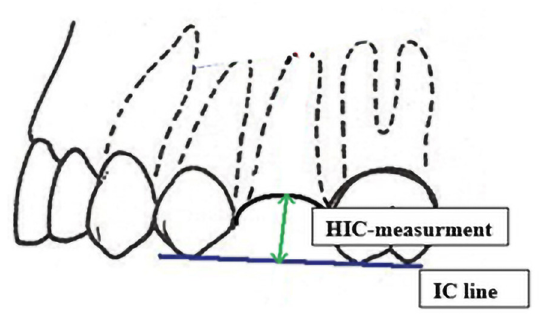
Figure 4. HIC distance measurement.